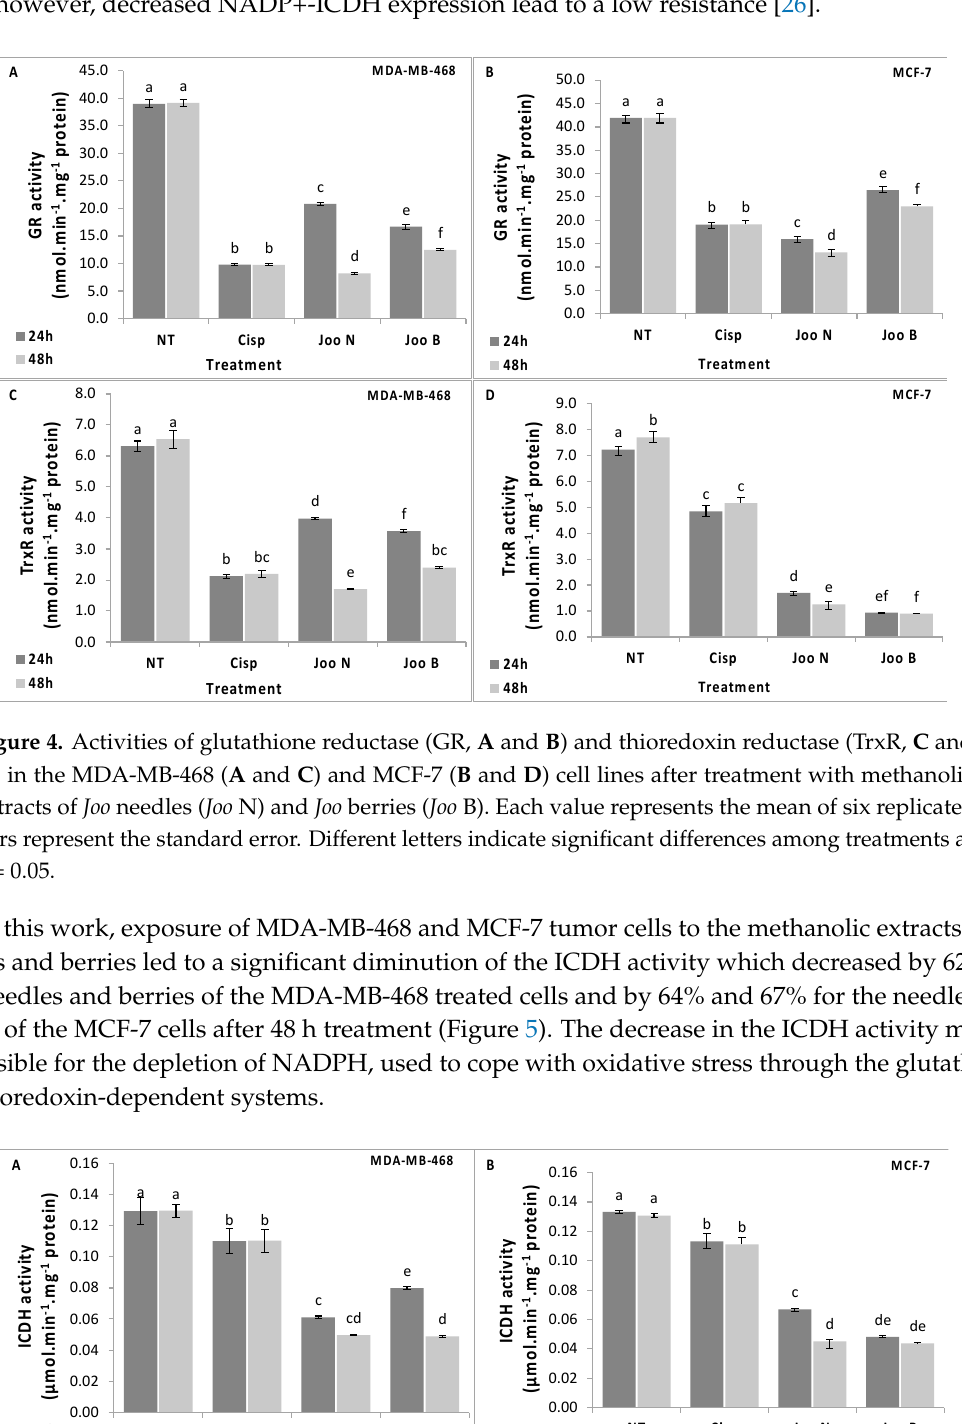
Figure 5. ICDH enzyme activity in the MDA-MB-468 ( A ) and MCF-7 ( B ) cell lines after treatment with methanolic extracts of Joo needles ( Joo N) and Joo berries ( Joo B). Each value represents the mean of six replicates. Bars represent the standard error. Different letters indicate significant differences among treatments at p = 0.05.